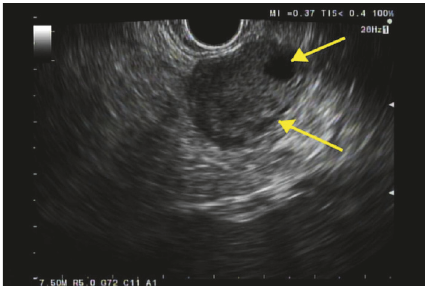
Figure 2: Fine needle aspiration during endoscopic ultrasound.